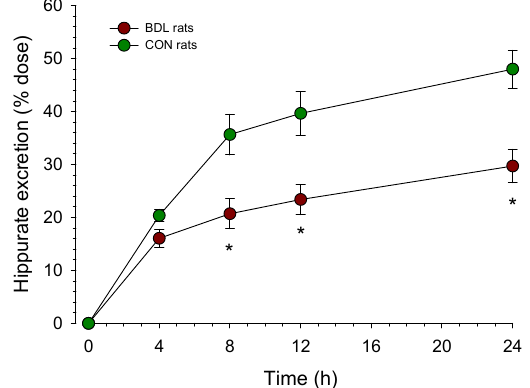
Figure 2. Urinary excretion of hippurate after the administration of benzoate. Rats were bile duct ligated for 4 weeks (BDL rats, n = 9) or sham-operated control rats ( n = 5). After the i.p. administration of 100 µmoles of benzoate per 100 g of body weight, urine was collected in individual portions from 0 to 4 h, 4 to 8 h, 8 to 12 h, and 12 to 24 h. The hippurate concentration was determined by HPLC, as described in Methods. Data are presented as mean ± SEM. * p < 0.05 vs. CON